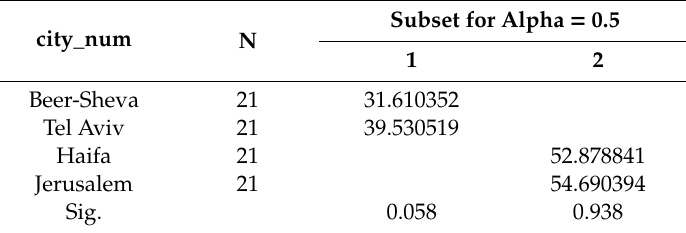
Table A3. ANOVA Results and a Post Hoc Analysis. Sche ff e a